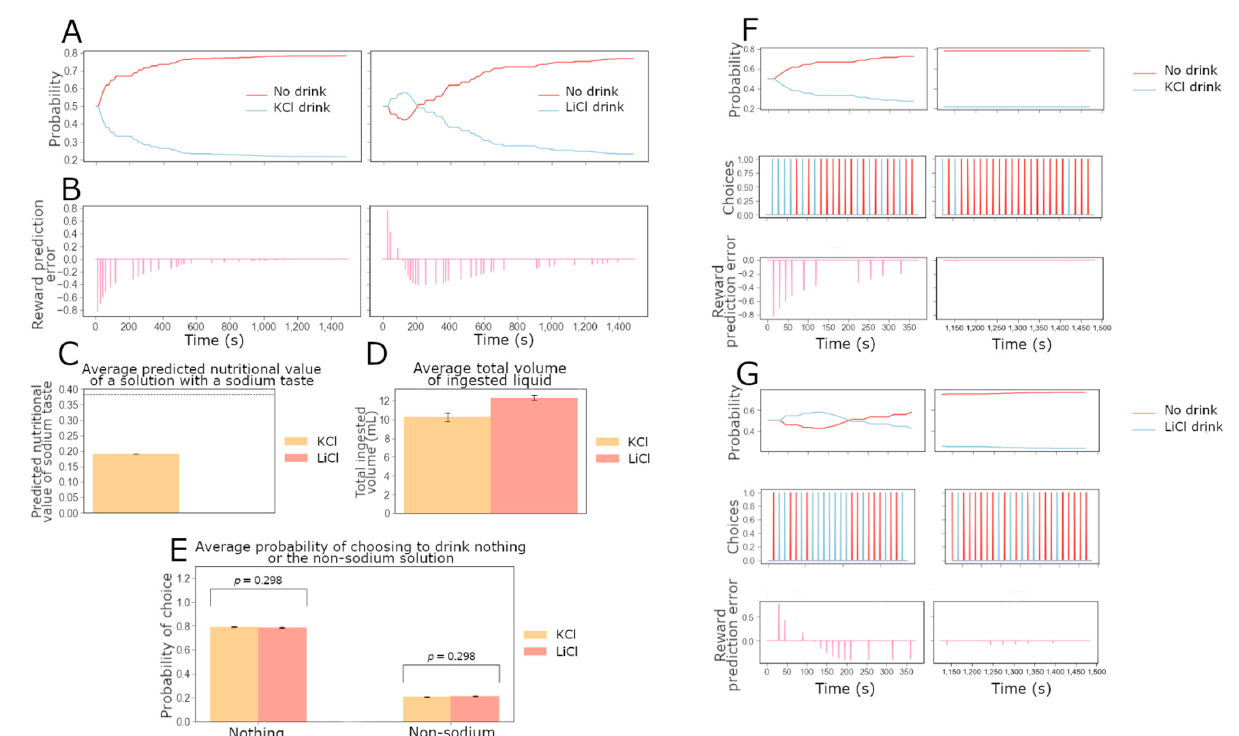
Figure 6. Model predictions on sodium-depleted rat behavior and dopamine dynamics when only non-sodium salt is available. Here we produce example simulated data for an experiment in which two sodium-depleted agents have access to only one salt solution: KCl only and LiCl only. Both versions of the experiment last 25 min (100 trials), divided into 5 sessions of 5 min (20 trials). ( A – E ) give example data for an optimized agent and average data for the experiment in which sodium- depleted agents have access to only one salt solution. For average data, 14 agents have access to KCl, while 15 agents have access to LiCl. The free parameter values for the agents in this group (N = 28) are all different and differ slightly from the optimized ones used for the example data. Both versions of the experiment last 25 min (100 trials), divided into 5 sessions of 5 min (20 trials). We show data for the entire 25 min experiment. ( A ) Evolution of the probability for an agent to drink KCl or nothing over time (left); probability to drink LiCl (right). ( B ) Reward prediction error signals for KCl (left) and LiCl (right). ( C ) Average predicted value of a lick of KCl (yellow) or LiCl (orange) based on the taste at the end of the 25 min experiment. The true nutritive value of one lick of sodium is indicated with a dotted line ( p = 2.02 × 10 − 30 ). ( D ) Average volumes of ingested liquid during the 25 min simulated experiments: KCl (N = 14) is shown in yellow and LiCl (N = 15) is shown in red ( p = 0.001). ( E ) Average probabilities to drink the available non-sodium solution (KCl in yellow or LiCl in orange). (( F ) top panels ): Example evolution of the probability of an agent to drink KCl or nothing over time during the first session (left) and the last session (right). (( F ) middle panels ): Choices between drinking KCl and nothing over time during the first (left) or last session (right). (( F ) bottom panels ): Reward prediction error signal over time during the first (left) or last session (right). (( G ) top ): Evolution of the probability for a simulated rat with optimized free parameters to drink LiCl or nothing over time during the first (left) or the last session (right). (( G ) middle ): Choices between drinking LiCl and nothing over time during the first (left) or last session (right). (( G ) bottom ): Reward prediction error signal over time during the first (left) or last session (right).